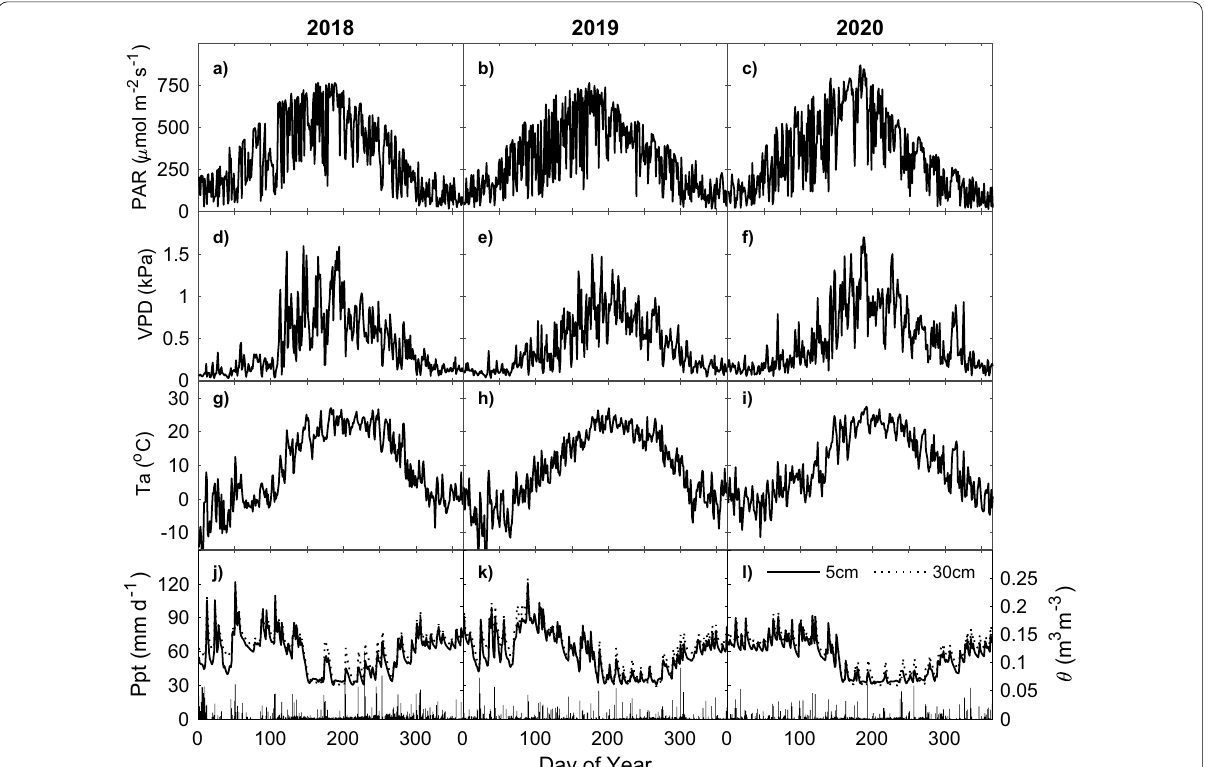
Fig. 2 Annual daily average measurements of photosynthetically active radiation (PAR; a – c ), vapour pressure deficit (VPD; d , f ), air temperature (Ta; g – i ); daily total precipitation (Ppt; j – l ) and daily average soil moisture (θ, j – l ) for years 2018, 2019 and